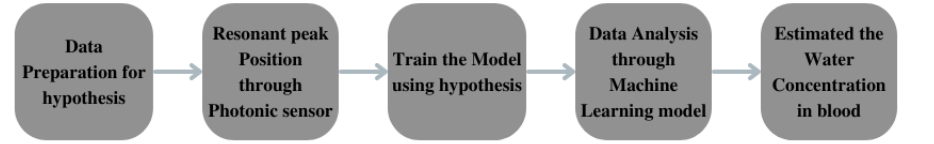
Figure 2. Machine Learning model for identification of hematological